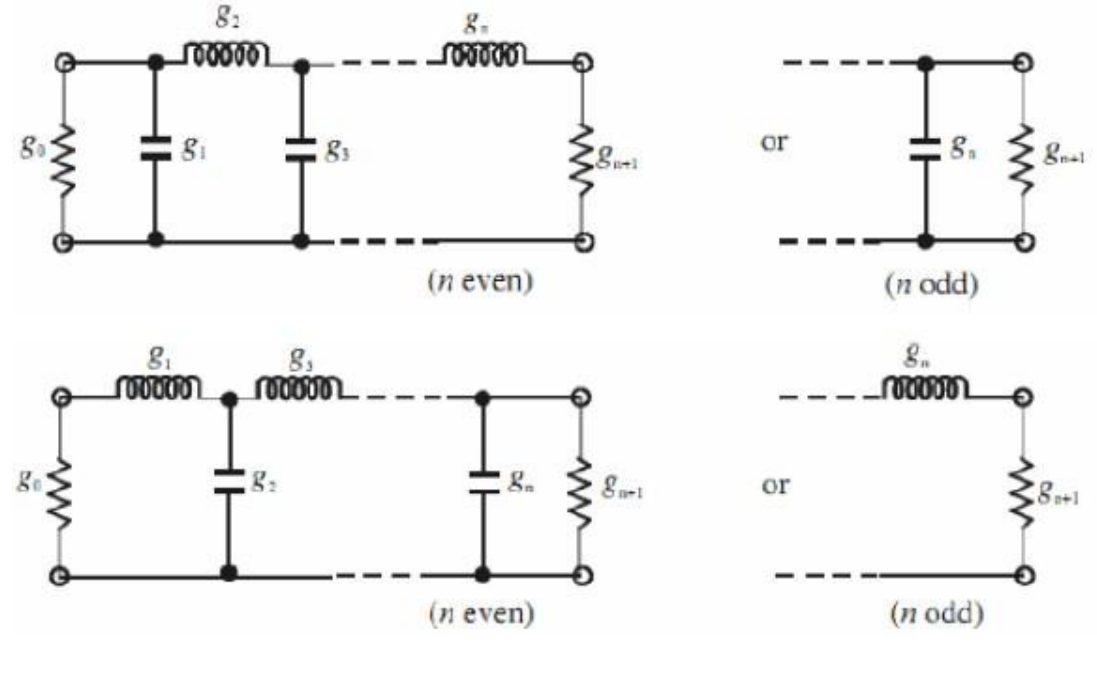
Figure 7. Filter’s design using LC components [8]